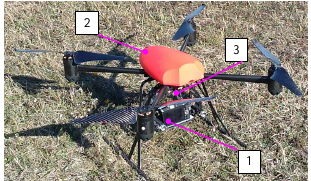
Figure 1. UAS and scientific payload. 1: camera, 2: drone, 3: